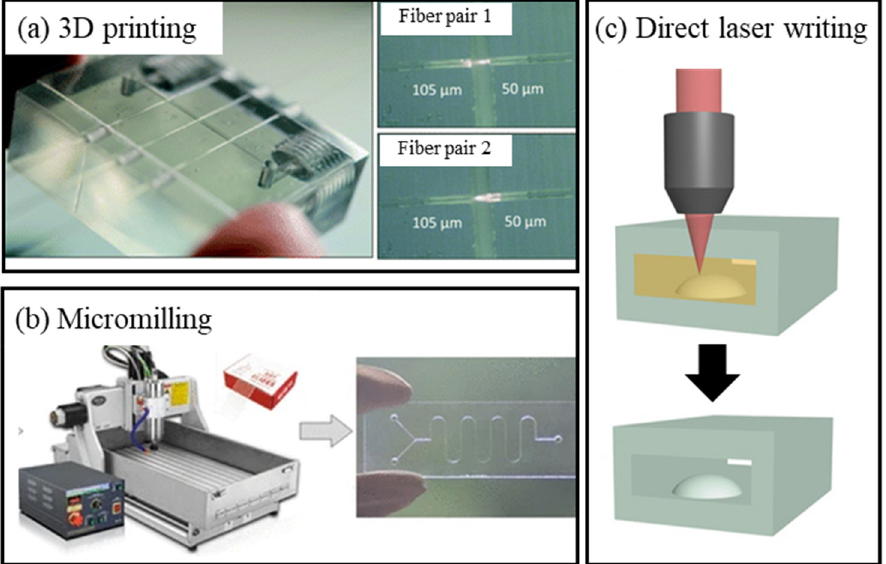
Figure 1. Direct manufacture of optofluidic devices using techniques: ( a ) 3D printing, ( b ) micromilling, ( c ) direct laser writing. ( a ) Reprinted with permission from ref [19], Copyright 2016, Royal Society of Chemistry; ( b ) Reprinted with permission from ref [22], Copyright 2018, Springer; ( c ) Reprinted with permission from ref [24], Copyright 2018.